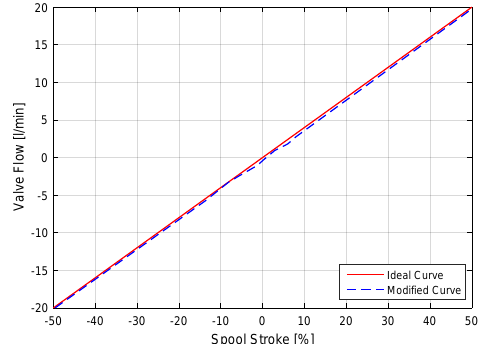
Figure 8: Initial comparison.